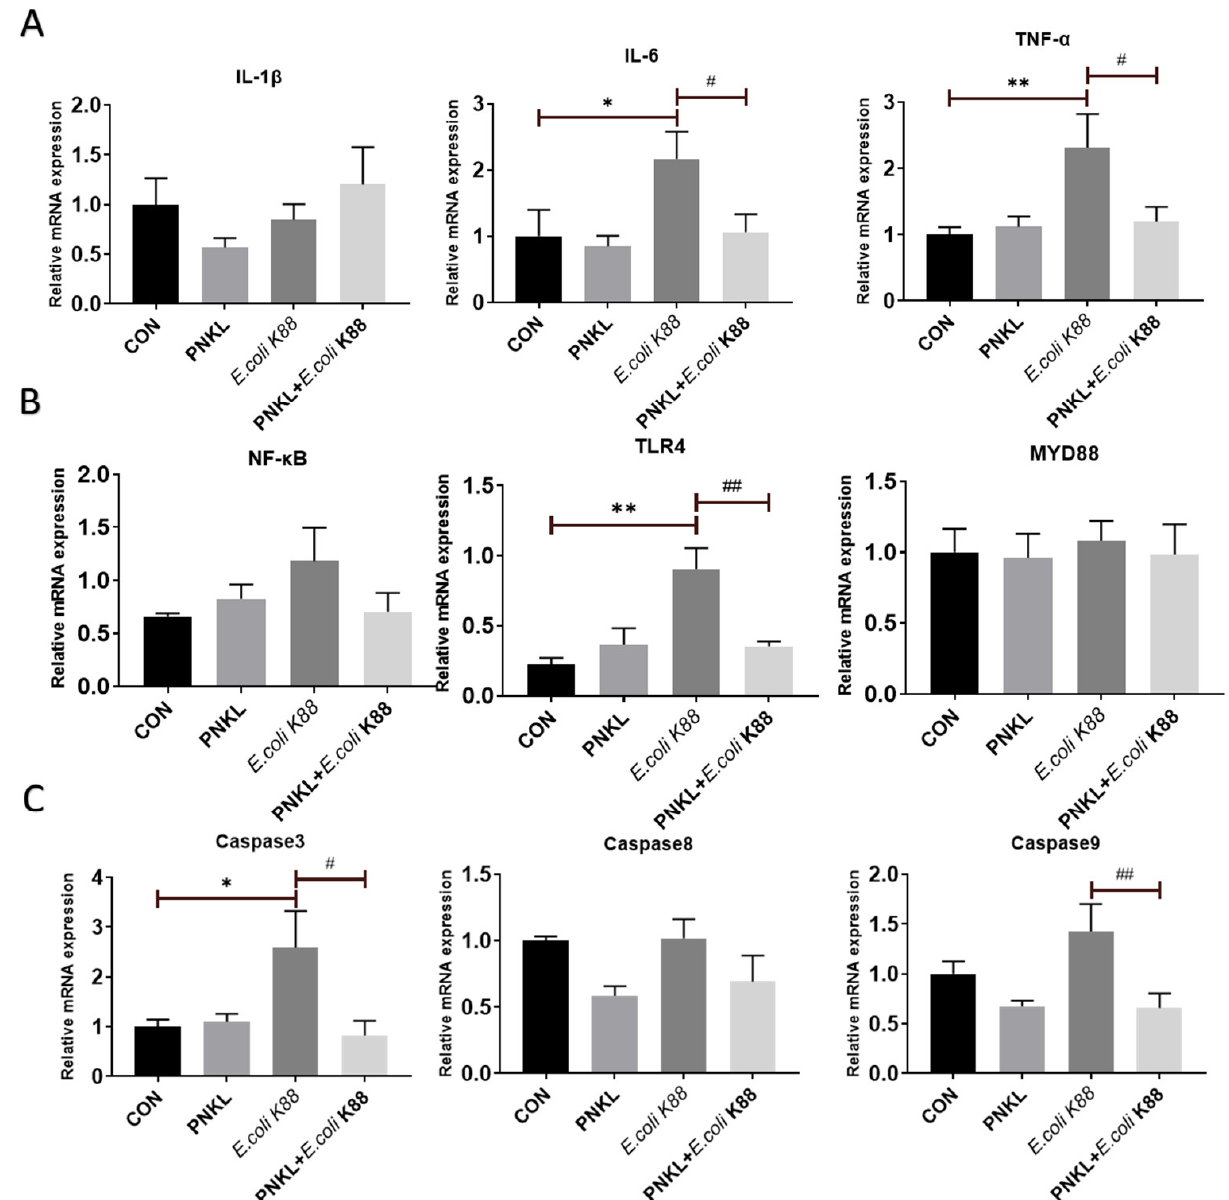
Figure 7. Influence of PNKL on E. coli K88-induced inflammatory responses in IPEC-J2 cells. Total RNA was extracted from IPEC-J2 cells and the expression of related genes were measured by real-time fluorescence PCR. The target gene mRNA expression level was calculated using the 2 – ∆∆ Ct method. ( A ) Gene expression of the NF- κ B signaling pathway key factors. ( B ) Gene expression of the apoptotic factor. ( C ) Gene expression of the proinflammatory cytokine. (D ) Protein level of the proinflammatory cytokine. * Means significant difference compared with blank control group ( p < 0.05), ** Means significant difference compared with blank control group ( p < 0.01), # Means significant difference compared with E. coli K88 control group ( p < 0.05), ## Means significant difference compared with E. coli K88 control group ( p < 0.01). IL-1 β , interleukin 1 beta; IL-6, interleukin 6; TNF- α , tumor necrosis factor alpha.